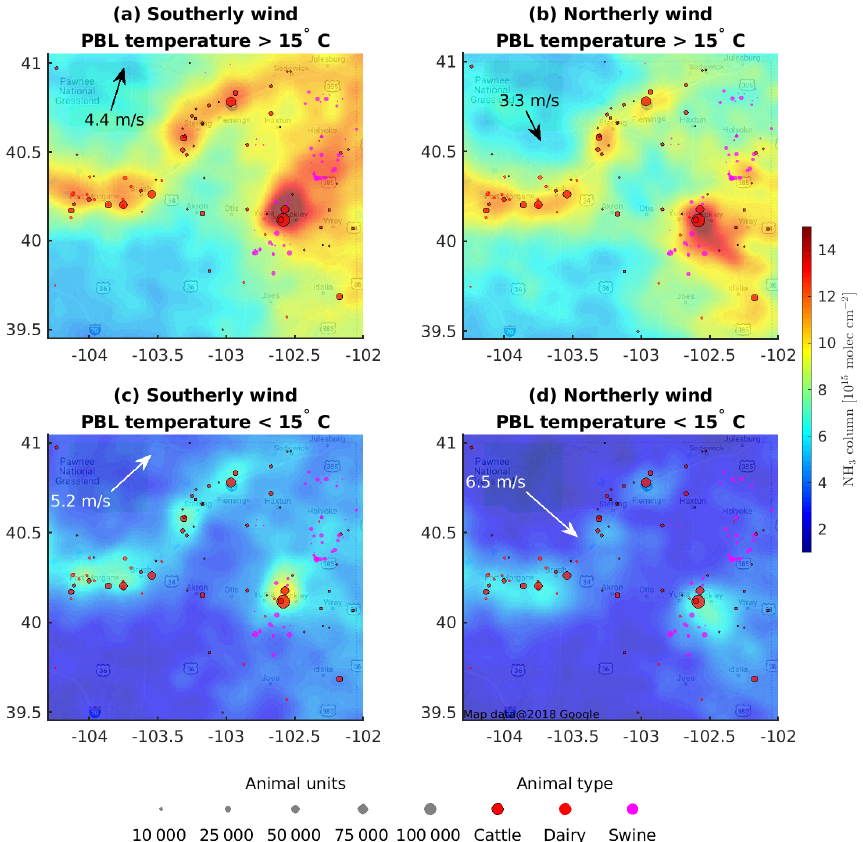
Figure 11. Physical oversampling results using IASI-A NH 3 total columns under southerly wind (a, c) and northerly wind (b, d) and high PBL temperature ( > 15 ◦ C, a, b ) and low PBL temperature ( < 15 ◦ C, c, d ). The text arrows show the average wind speed and wind direction at the locations and times of all IASI observations in each category. The size and location of large CAFOs are